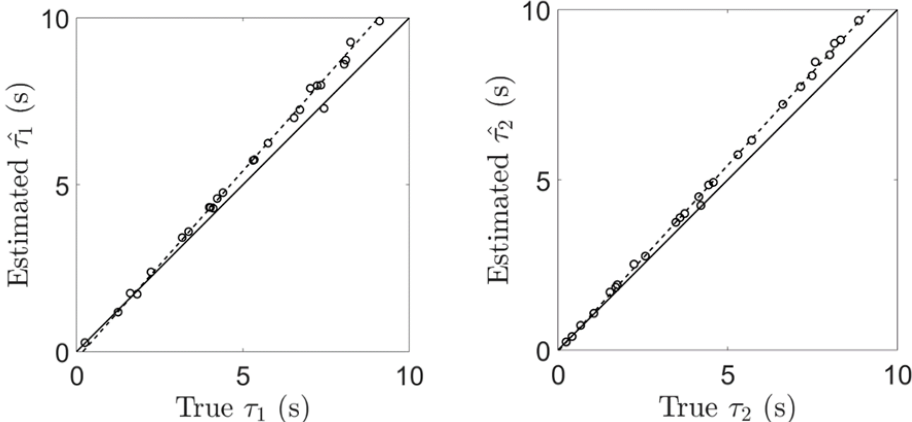
Figure 10. Blind identification of the time constants 𝜏 1 and 𝜏 2 for two simulated MOX sensors. Experiments with simulated MOX sensors (same conditions as in Figure 6). The blind identification method leads to a valid, but biased, estimate: 𝜏 1 ̂ = 1.1 𝜏 1 and 𝜏 2 ̂ = 1.1 𝜏 2